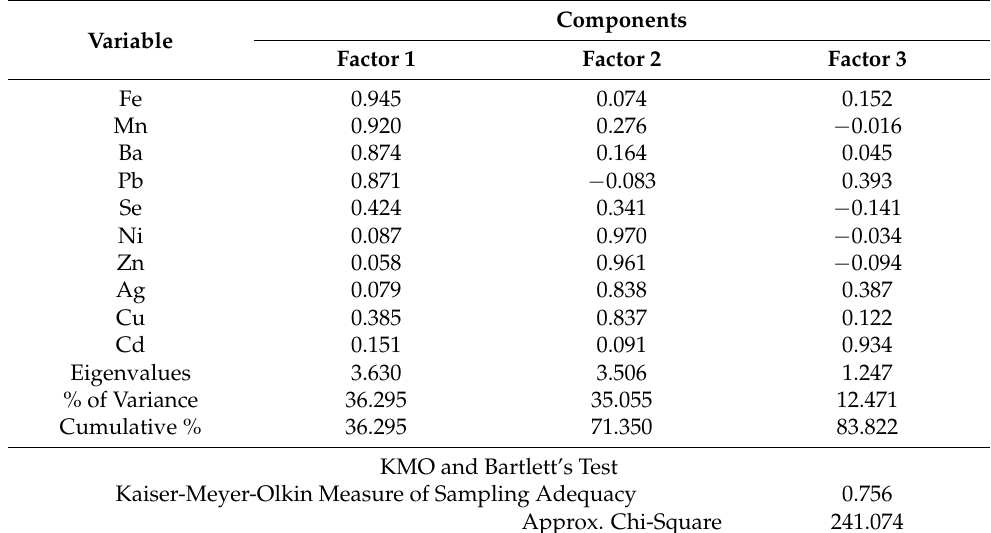
Table 4. Varimax rotated component matrix for trace elements.